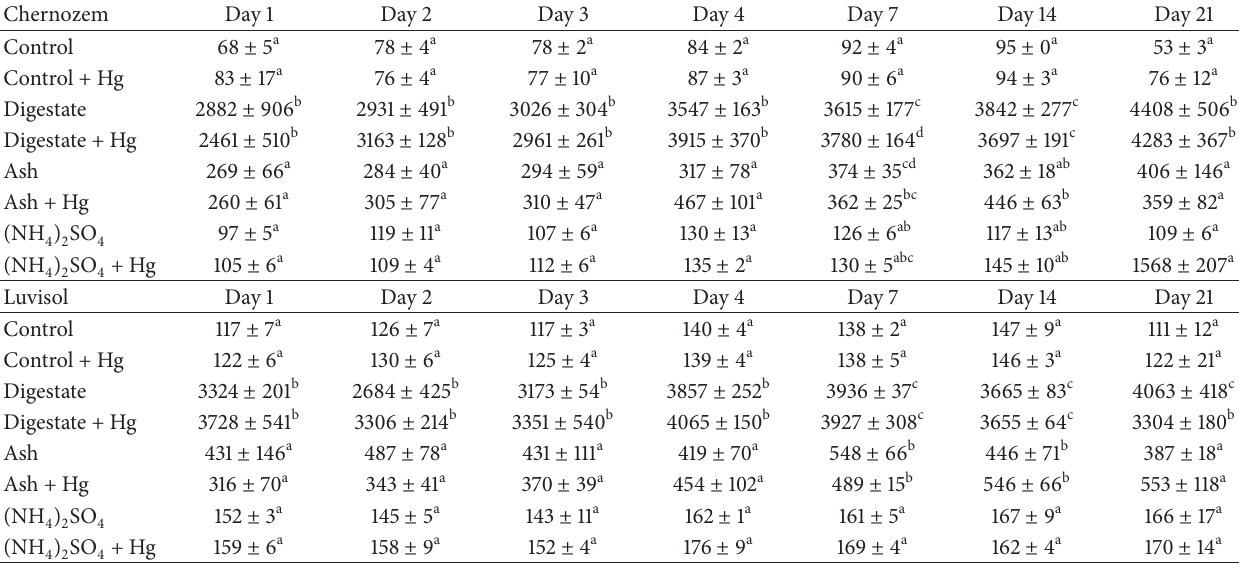
Table 5: The concentrations of K extractable with 0.11mol L − 1 acetic acid within the incubation experiment (mg ⋅ kg − 1 ); the averages marked by the same letter did not significantly differ at 𝑃 < 0.05 within individual columns; data are presented as mean ± standard deviation ( 𝑛 = 3 ).